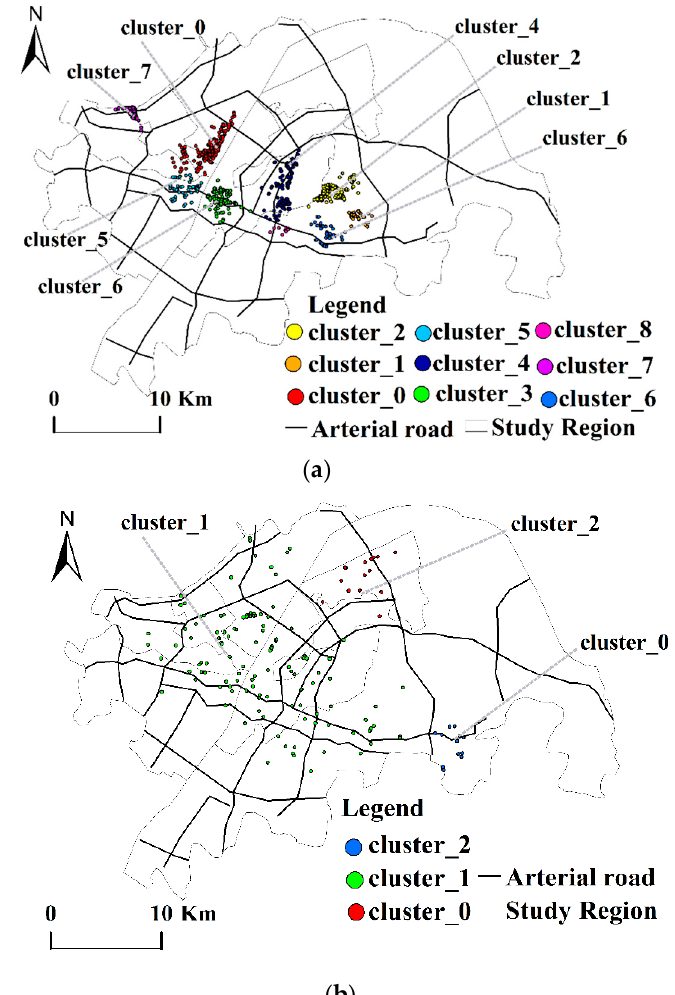
Description: Parks and wetlands (301), Scenic Spots (302). Bold numbers indicate that the cluster density is greater than or equal to the mean of all clusters.